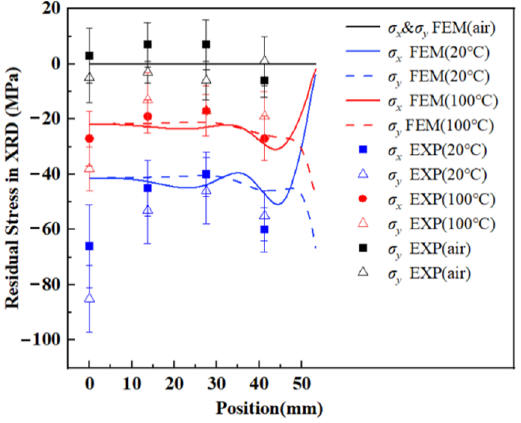
Figure 11. Simulation and experimental results of RS in XRD along path AB.